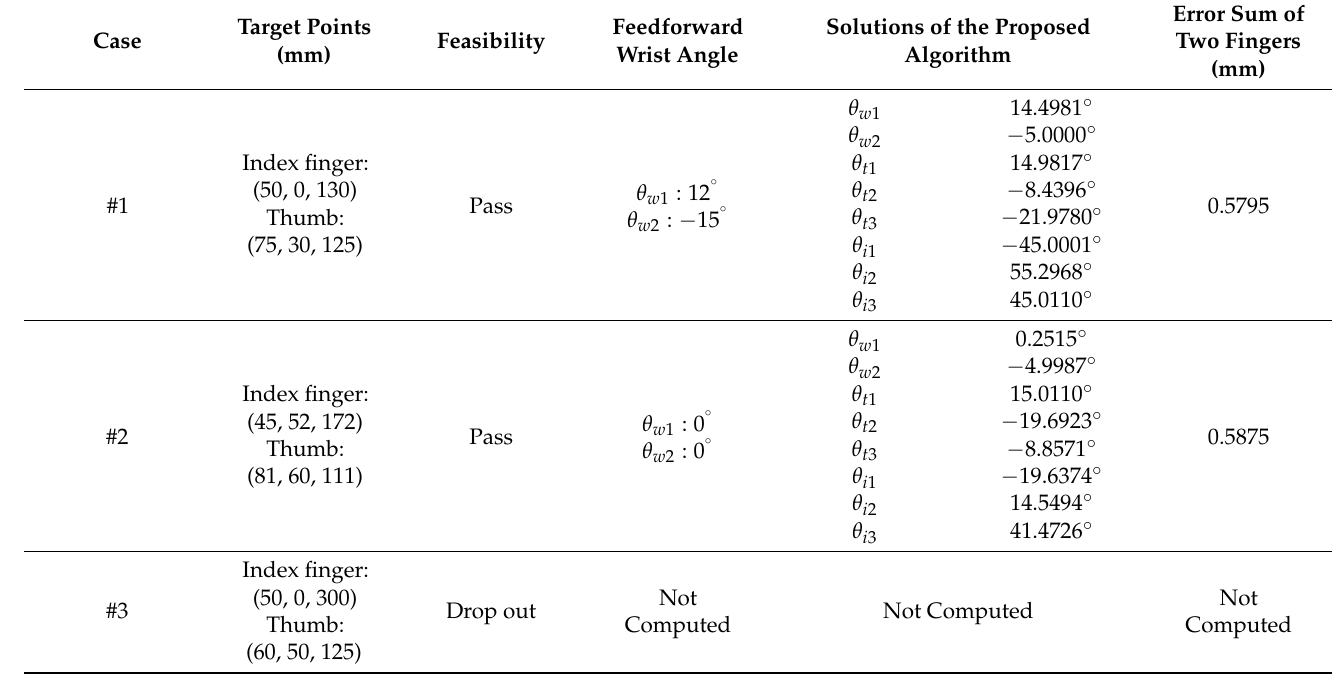
Table 5. Results of illustrated cases performed by the proposed